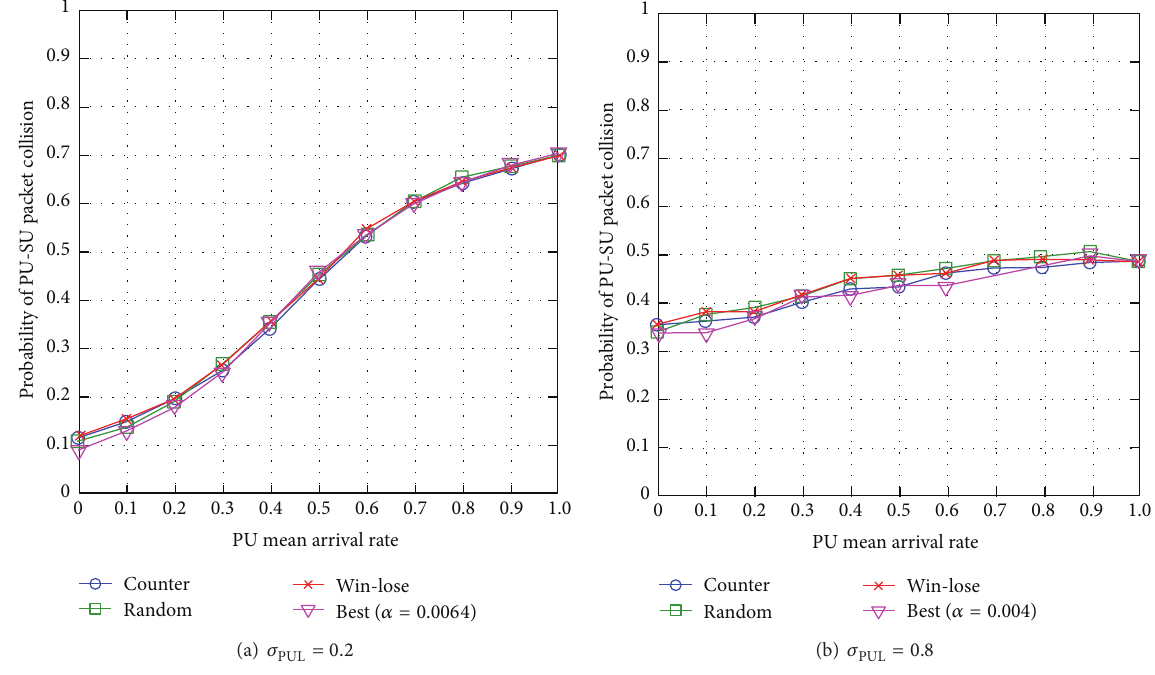
Figure 16: SUs’ interference to PUs for varying PU mean arrival rate 𝜇